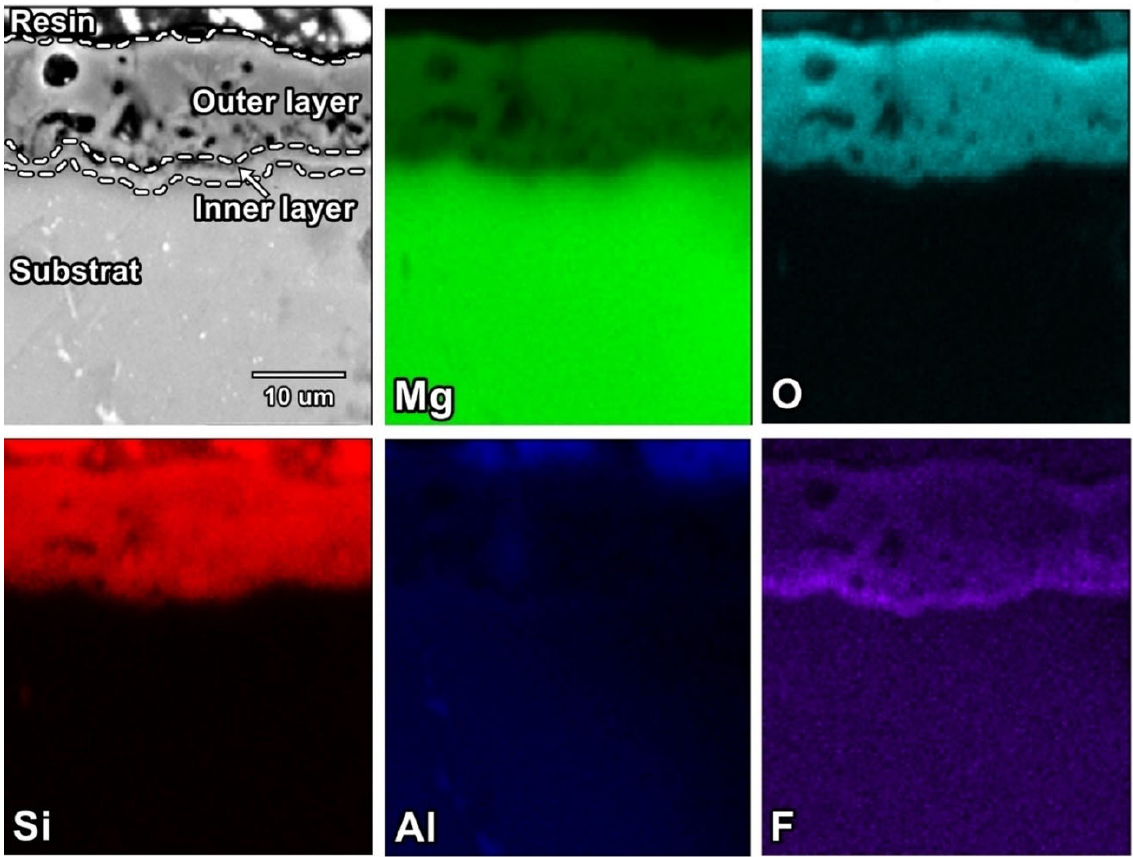
Figure 5. Microstructure and elemental distribution in the cross ‐ section of the BF4 coating.